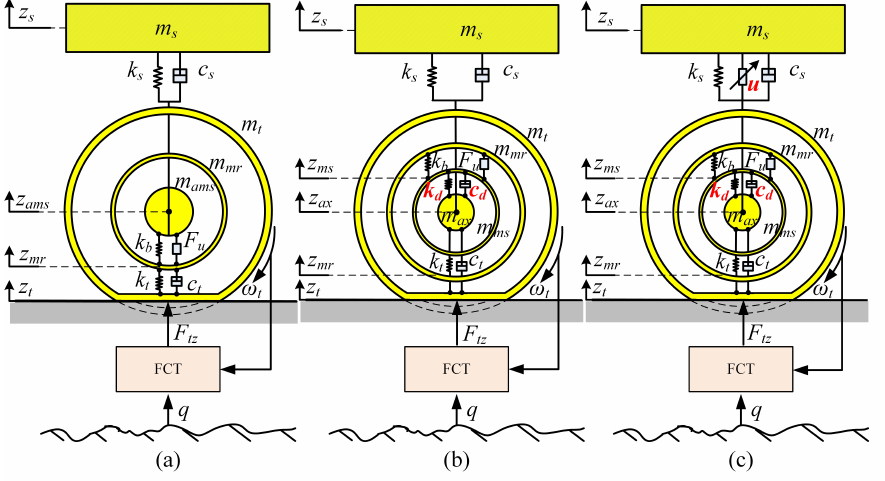
Figure 7. Quarter vehicle models equipped with the IWM: ( a ) passive suspension, ( b ) DVAS, ( c ) ASS and